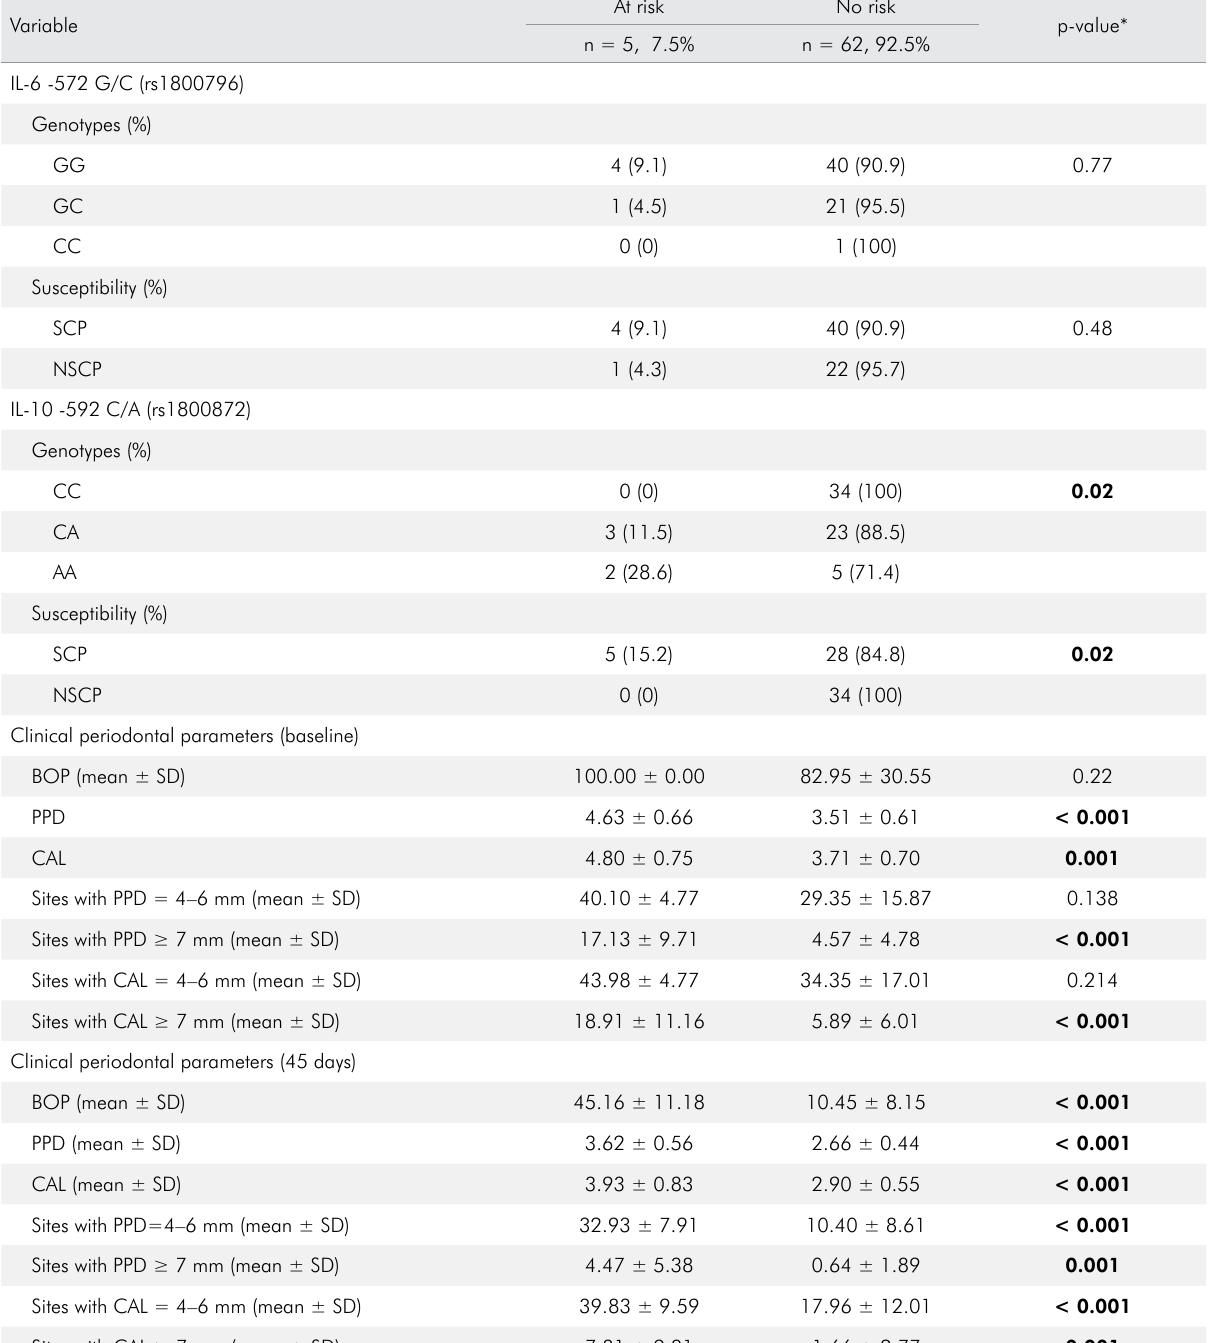
Table 4. Distribution of IL-6 -572 G/C (rs1800796) and IL-10 -592 C/A (rs1800872) genotypes as well as clinical periodontal parameters at baseline and the 45 th day following periodontal treatment among individuals at risk or not at risk of periodontal disease progression as determined by the full-mouth bleeding